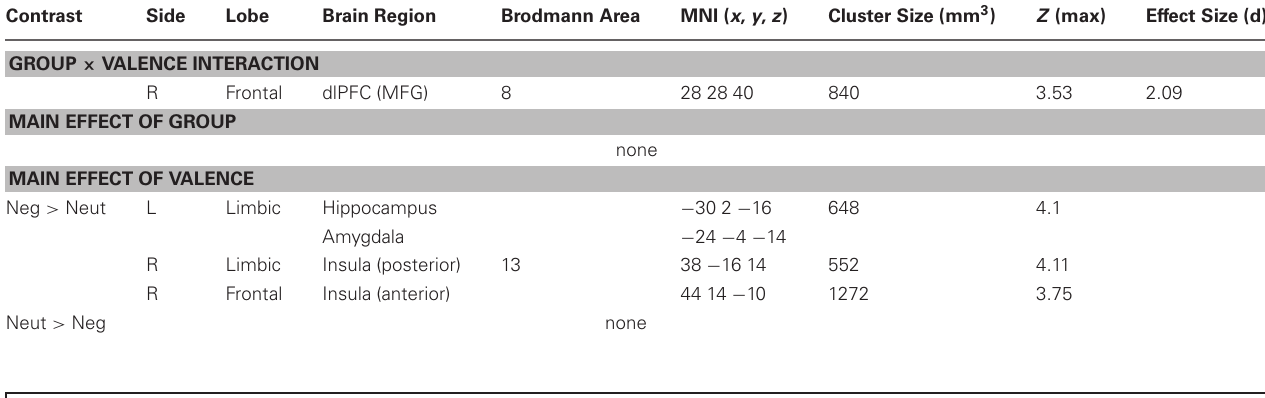
Table 3 | BOLD response to viewing trials.